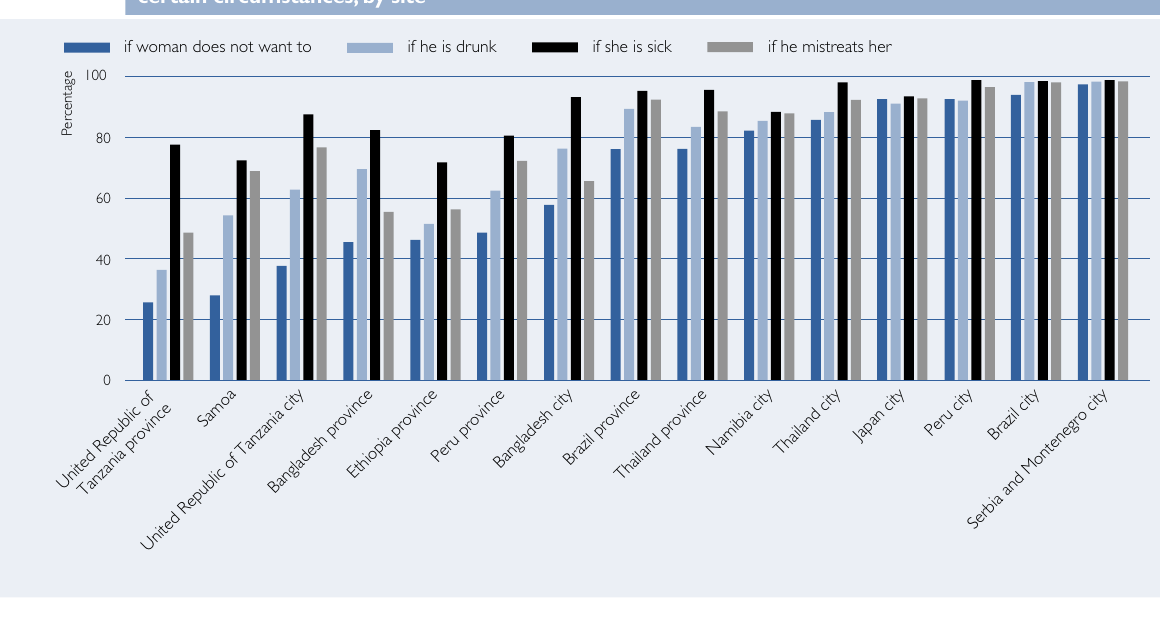
Percentage of women believing that a wife has a right to refuse to have sex with her husband under certain circumstances, by